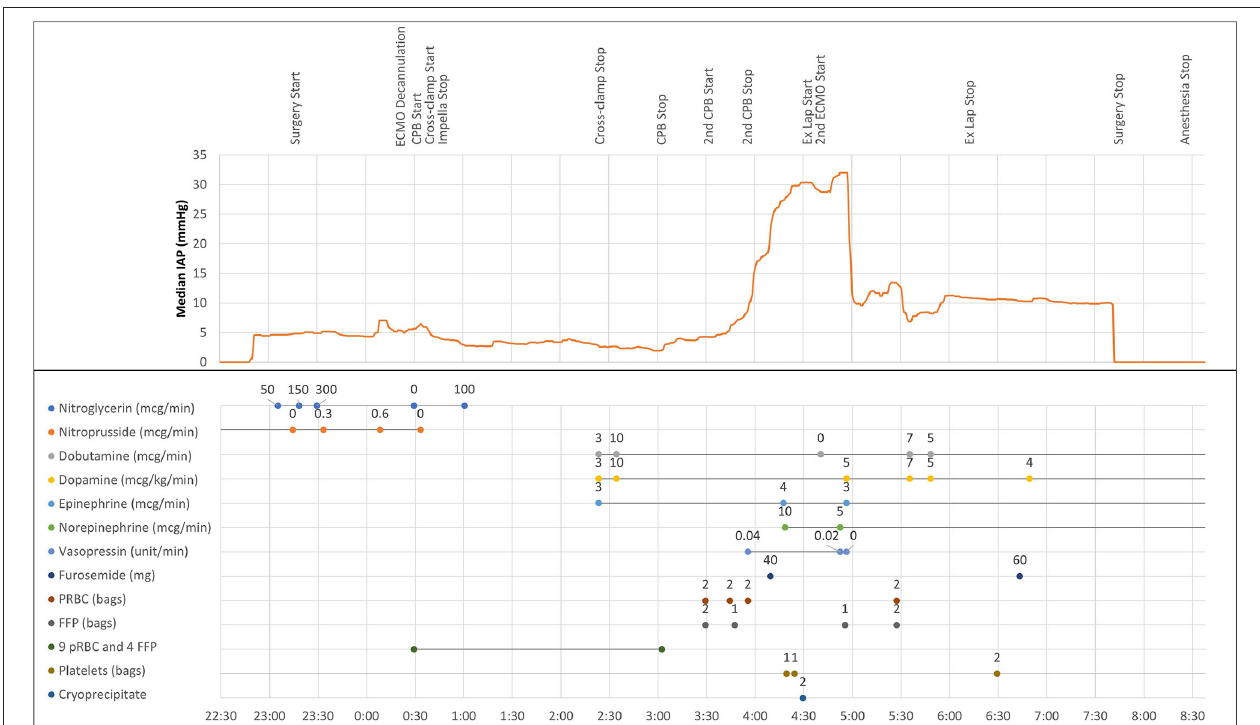
FIGURE 2 | Intraoperative intra-abdominal pressure trendline and clinical timeline, including vasoactive medications and transfusion of blood products. Intra-abdominal pressure measurements were downloaded from the Accuryn Monitoring System. ECMO, extracorporeal membrane oxygenation; CPB, cardiopulmonary bypass; ex lap, exploratory laparotomy; pRBC, packed red blood cells; FFP, fresh frozen plasma.